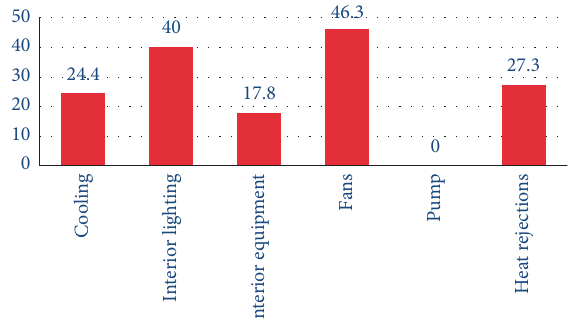
Figure 8: Percentage power savings achieved due to ECBC compliant electrical